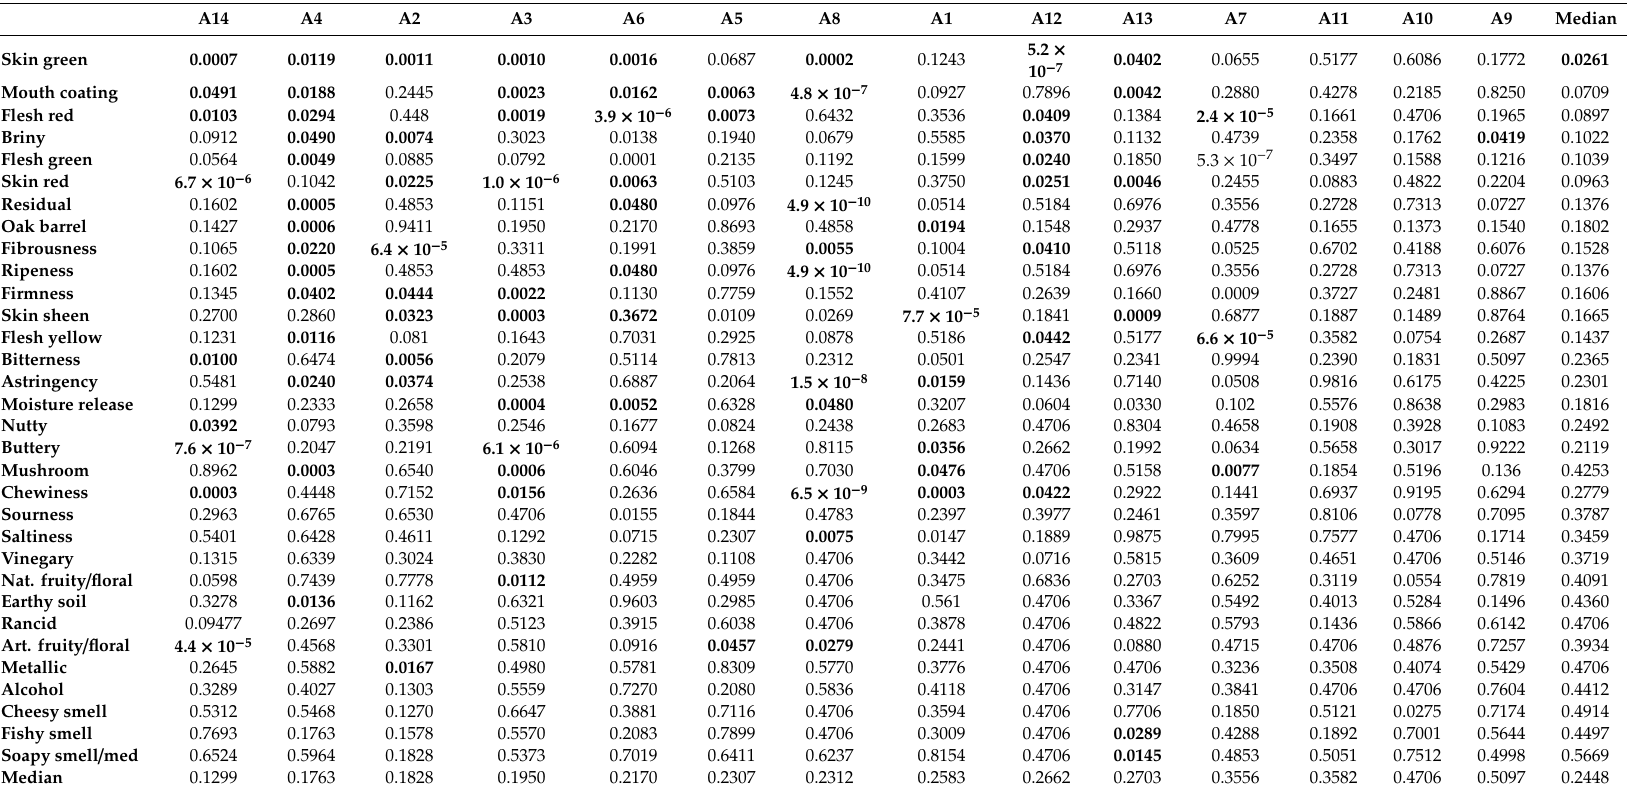
Table 2. Discriminant power of panelists as assessed by the p -value of the F